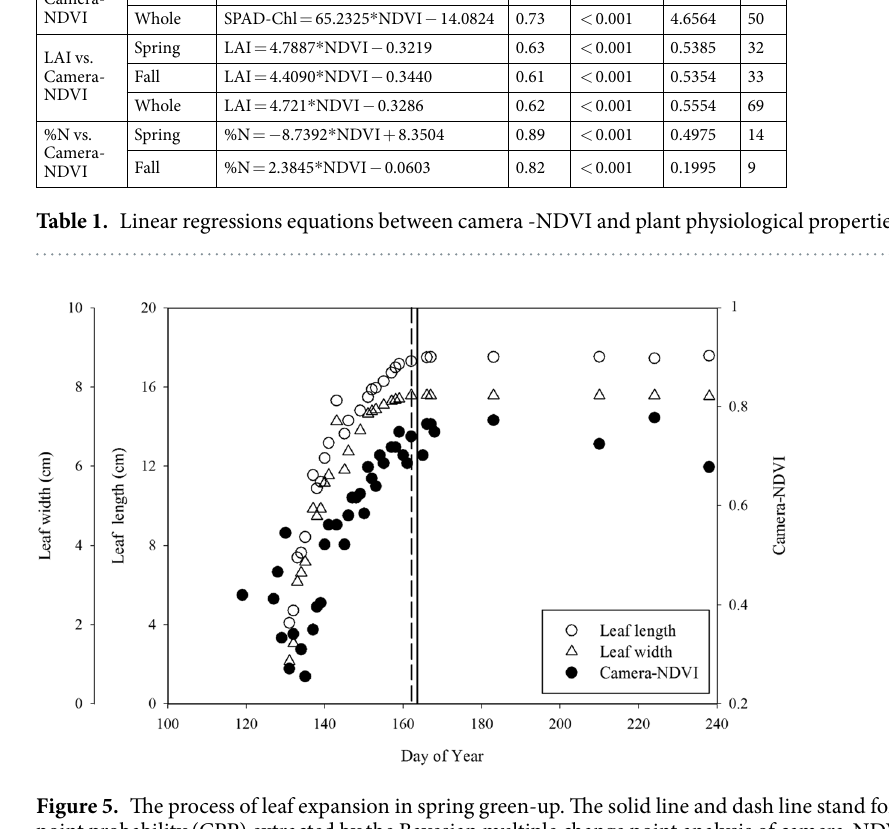
Figure 5. The process of leaf expansion in spring green-up. The solid line and dash line stand for the change point probability (CPP) extracted by the Bayesian multiple change point analysis of camera-NDVI and leaf size (length and width) in late spring,